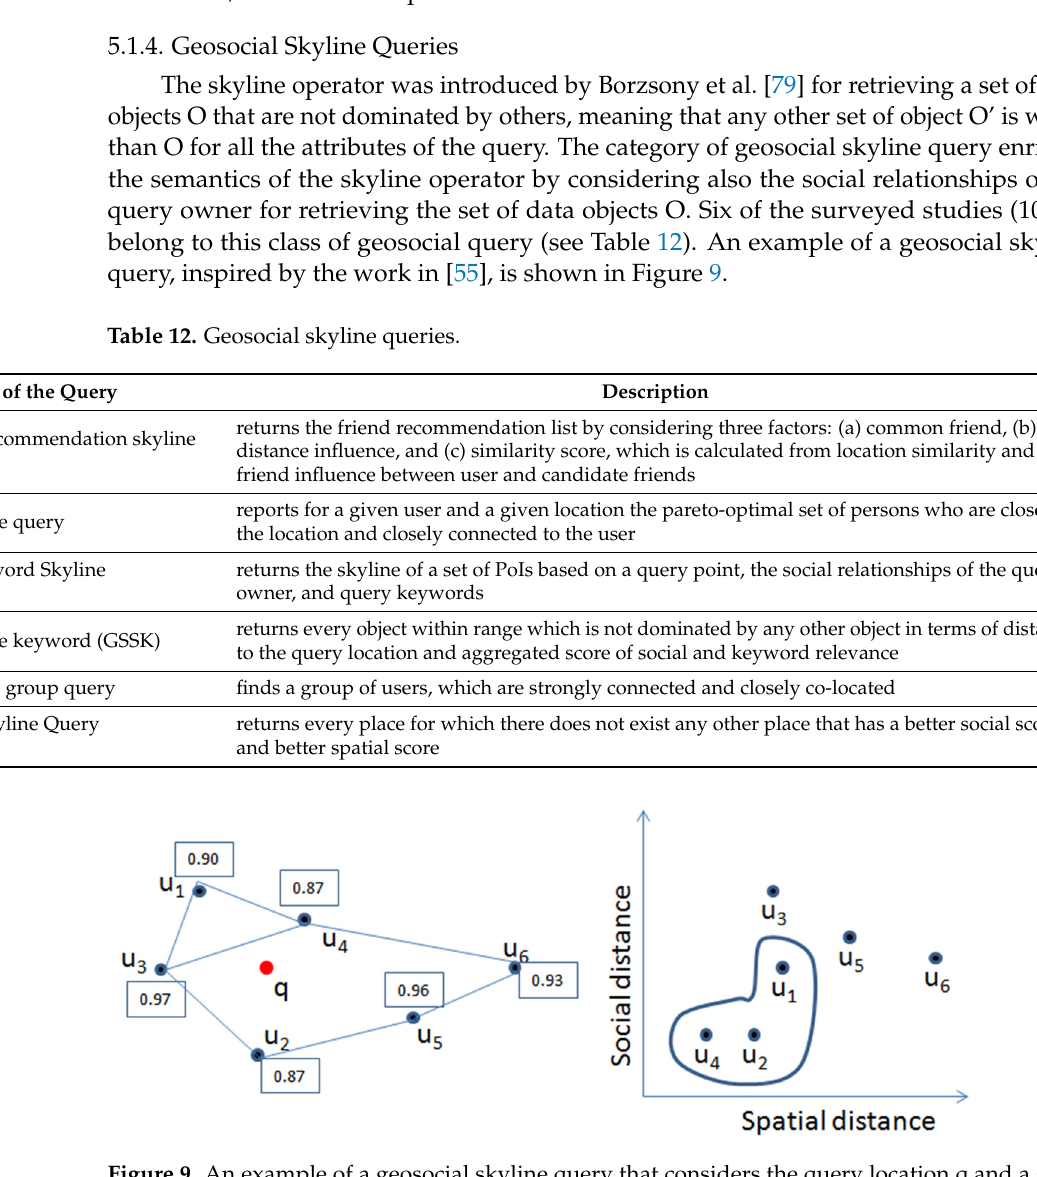
Figure 9. An example of a geosocial skyline query that considers the query location q and a set of users {u 1 , u 2 , …, u 6 } with the social distance of each user from q indicated in the labels. The query returns the set of users {u 1 , u 2 , u 4 } according to the social and spatial distance in the skyline space. Similarly to the category of geosocial top-k queries, all the studies proposing geoso- cial skyline queries apply the distance as a spatial constraint of the query.